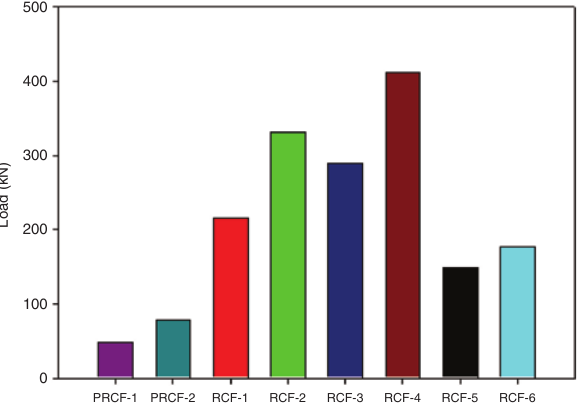
Figure 9: Load carrying capacities of the test frames.